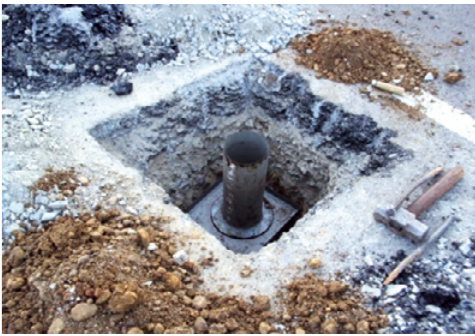
Figure 4. Observation of test pits Figure 5. Field density